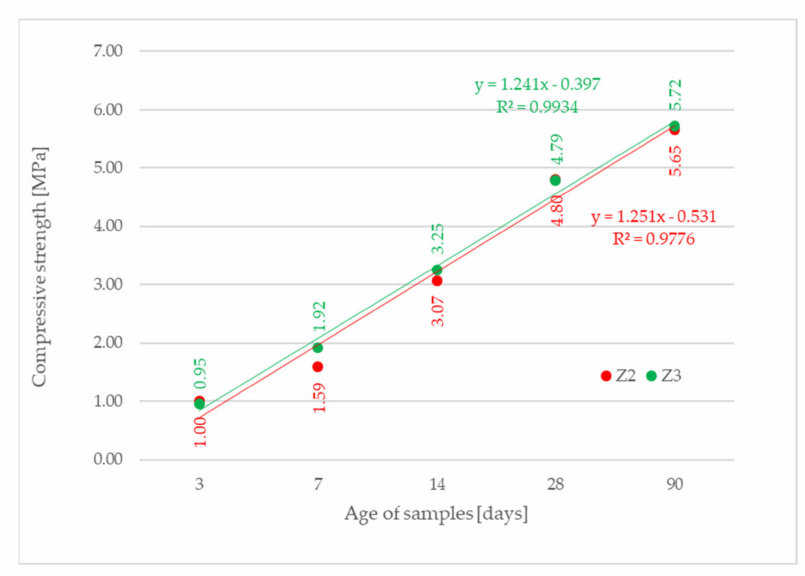
Figure 5. Graphical expression of Compressive strength of mixtures Z2 and Z3.